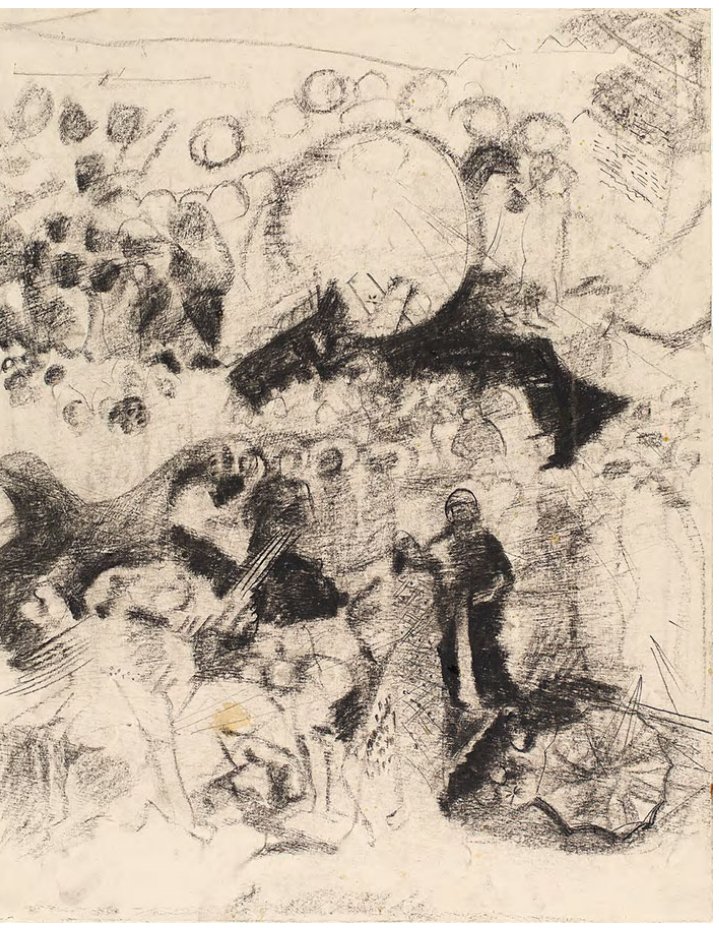
Figure 6. Vasily Chekrygin, The Raising of the Dead , 1920 – 1921, pencil and charcoal on paper, State Tretyakov Gallery, Moscow.